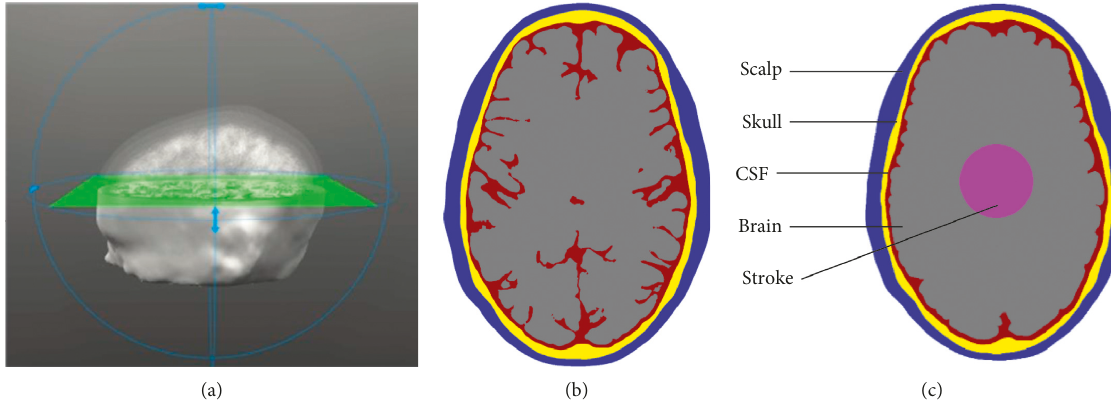
Figure 1: Baseline imaging for human head mold production: (a) cross section of the human head obtained from an MR image, (b) the 2D raw segmentation model of the main human head tissue layers, and (c) a simplified anatomical model with an added stroke